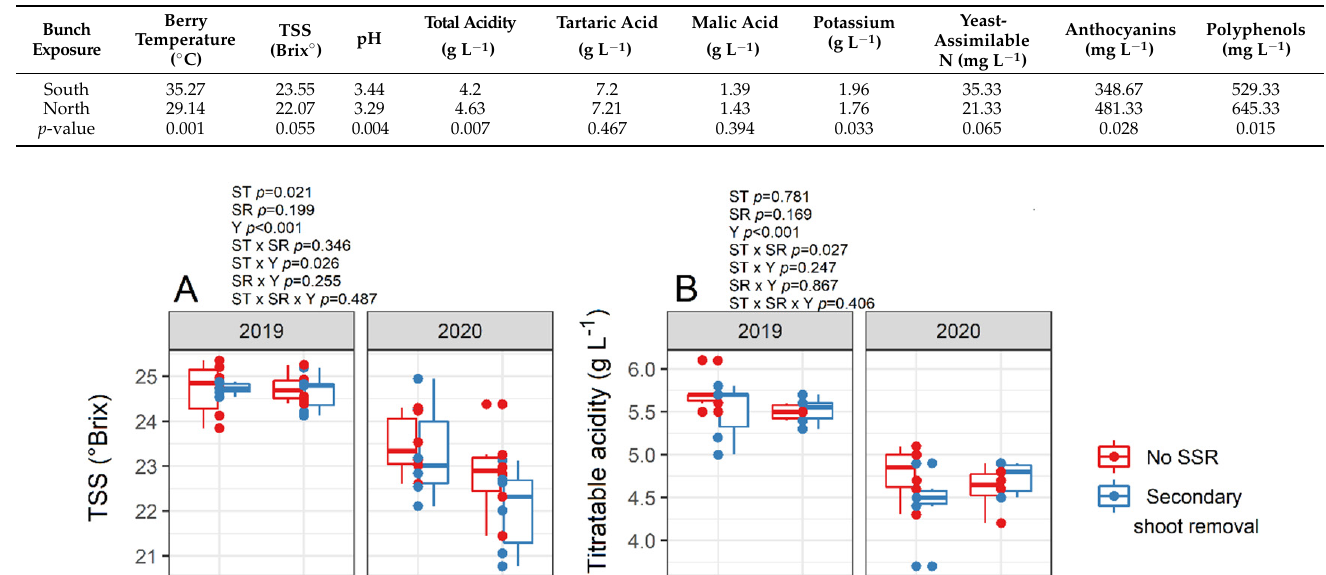
Figure 5. Total soluble solids (TSS, ( A )), titratable acidity ( B ), must pH ( C ), tartaric acid ( D ), malic acid ( E ), total anthocyanins ( F ), yeast available nitrogen ( G ), and total polyphenols ( H ) in plants subjected to shoot topping or shoot bundling (no ST) where secondary shoots were either removed (secondary shoot removal) or not (no SSR) (n = 24). In the graphs, points represent raw data, hori- zontal lines within boxes indicate the median, and boxes indicate the upper (75%) and lower (25%) quartiles. Whiskers indicate the ranges of the minimum and maximum values. Data were analyzed with three-way ANOVA and p -values are shown in the graph (ST—shoot topping factor; SR—sec- ondary removal factor; ST × SR—interaction).